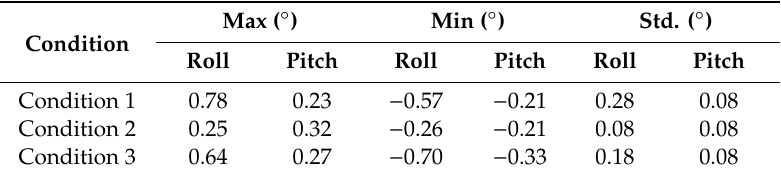
Figure 10. The time history and statistics of the vessel’s pitch angle. Table 3. Statistics of roll and pitch motions.